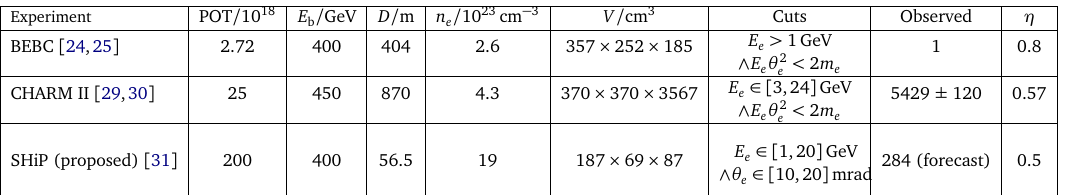
Table 1: The relevant experimental parameters for BEBC and CHARM II, and those projected for SHiP. POT is the total number of protons on target, either actual or predicted. E is the energy of proton beam. D is the distance from the end of the b target to the beginning of the detector. n is the detector’s electron density; in the e case of CHARM II and SHiP, an effective density is given to account for their active layers. V is the detector volume written as transverse area × length; the dimensions of BEBC are given approximating the detector as a cuboid. Cuts are placed on the kinetic energy of the electron E and on the angle θ between the beam axis and e e recoil electron. The number of observed events is given for BEBC and CHARM II, and the expected background for SHiP. The detection efficiency after cuts is denoted η